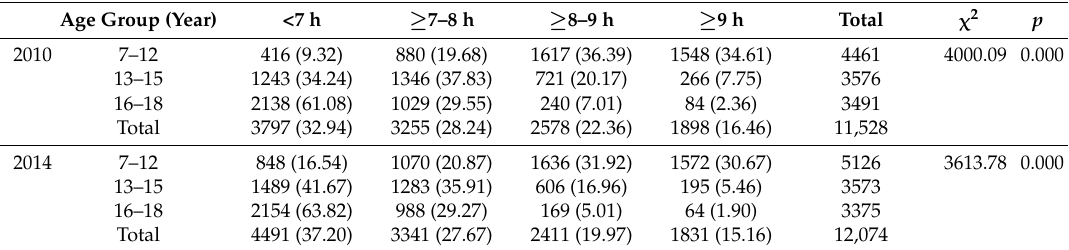
Table 5. Different sleep duration among age groups in 2010 and 2014